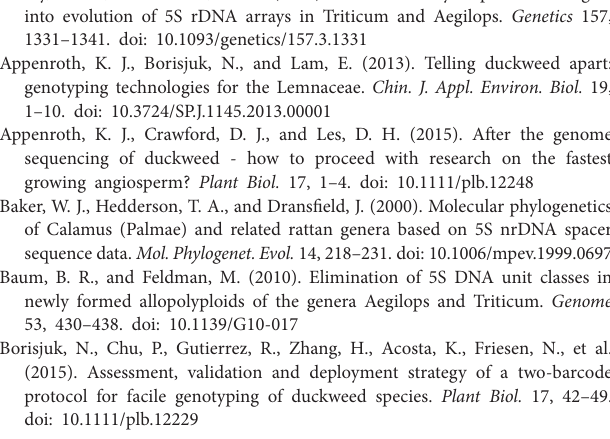
Supplementary Figure S1 | Schematic representation of pAS-Lp1 and pAS- Lp-2 plasmids containing sequences of 25S rDNA (yellow), 5S rDNA (green), and the sequences of single copy genes for nitrate reductase (NR; dark blue) and nitrite reductase (NiR; violet). The specific primer pairs to amplify each reference gene are as follows: 5 ' -TCCCACTGTCCCTGTCTACT/5 ' - CCCACTTATCCTACACCTCT for 25S rDNA; 5 ' -GGGTGCGATCATACCAGCAC/5 ' - GGGTGCAACACGAGGACTTC and 5 ' -GGGTGCGATCATACCAGCAC/5 ' - GGGTGCAACACGAGGACTTC for 5S rDNA; 5 ' -ATTTTCCTTTCCGCCACC/5 ' -